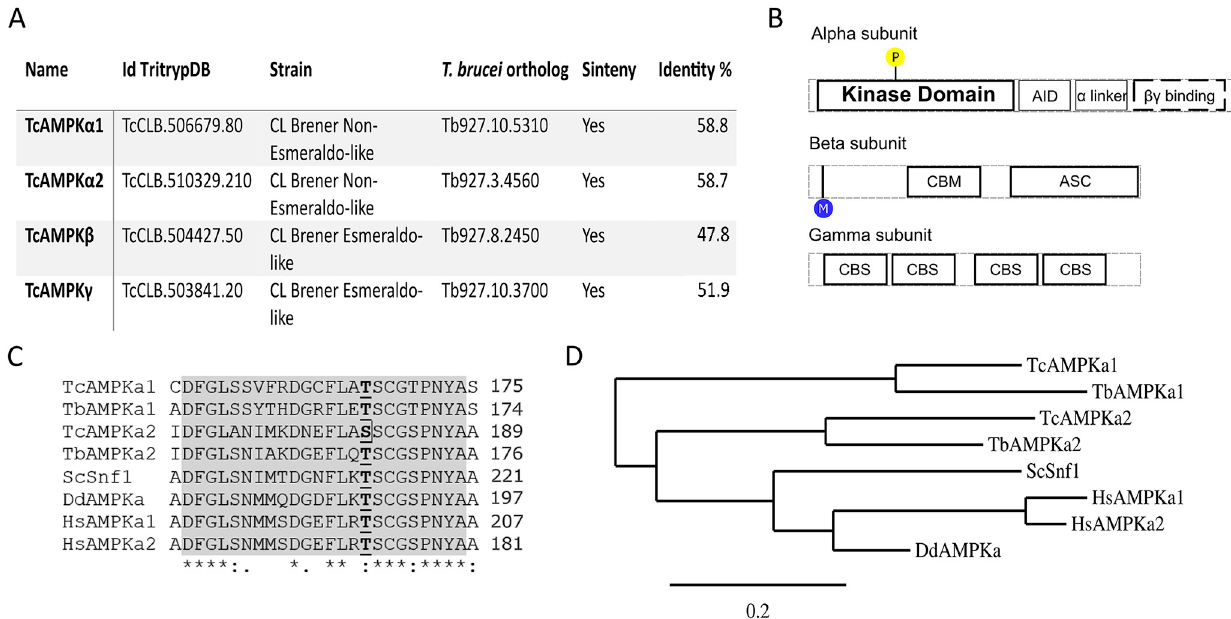
Fig 1. AMPK is partially conserved in T . cruzi . ( A ) Table of IDs for TcAMPK subunits and the percentage of identity with respect to their orthologous in T . brucei . ( B ) Protein domains of every TcAMPK subunit. Domains with a dark border line are conserved in T . cruzi , while domains with dashed lines borders are only partially conserved. AID and α linker domain could not be identified in T . cruzi catalytic subunits. Domain abbreviations: autoinhibitory domain (AID), carbohydrate-binding module (CBM), association with the SNF1 complex (ASC), cystathionine beta-synthase (CBS). ( C ) Section of the multiple alignment of the alpha subunits of several eukaryotic organisms ( Homo sapiens , Saccharomyces cerevisiae , Dictyostelium discoideum , Trypanosoma brucei and Trypanosoma cruzi ). The activation loop conserved region is painted in grey, and the Threonine (or Serine) residue phosphorylated during AMPK activation is in bold font and underlined. ( D ) Phylogenetic tree of the full-length multiple sequence alignment in C. The evolutionary history was inferred using the Neighbor-Joining method [33]. The tree is drawn to scale, with branch lengths in the same units as those of the evolutionary distances used to infer the phylogenetic tree. The evolutionary distances were computed using the JTT matrix-based method [34] and are in the units of the number of amino acid substitutions per site. This analysis involved 8 amino acid sequences. All positions containing gaps and missing data were eliminated (complete deletion option). There were a total of 521 positions in the final dataset. Evolutionary analyses were conducted in MEGA X